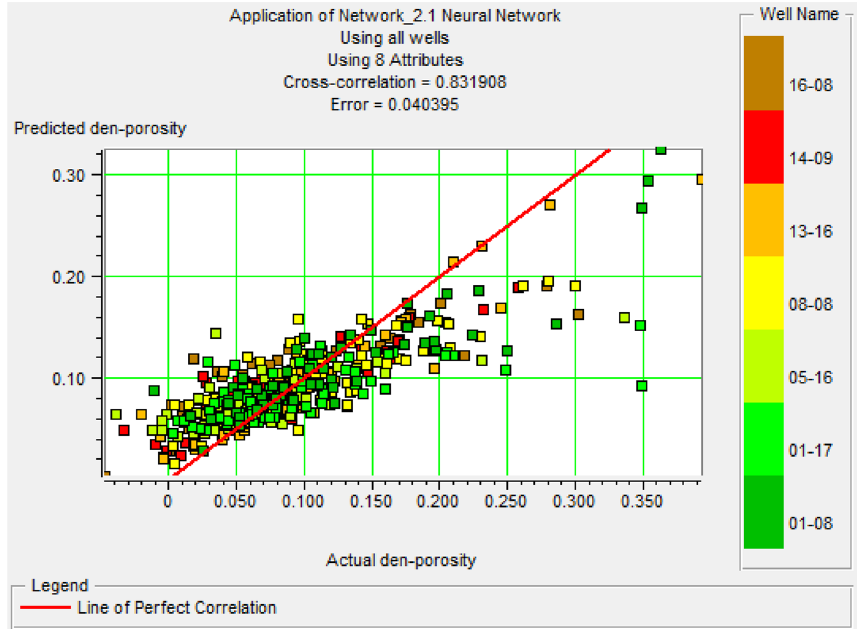
Fig. 21 Diagram porosity esti- mates versus actual porosity for the second category using the network